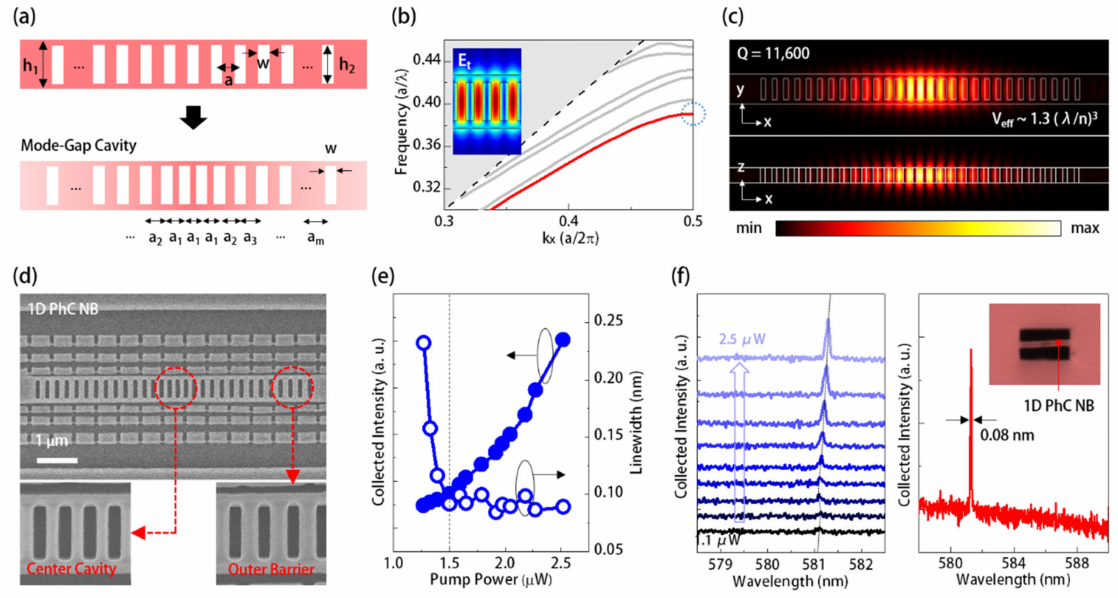
Figure 3. ( a ) Schematics and lattice parameter definitions of 1D PhC NB on a dye-doped PMMA thin film and the nanocavity formed by linearly increased lattice constants; ( b ) theoretical TE -like band diagram of 1D PhC NB with w , h 1 , h 2 , a , and t of 110, 700, 500, 220, and 300 nm; ( c ) theoretical E t distributions of the dielectric mode confined in the 1D PhC NB cavity along XY - and XZ -planes; ( d ) top- and zoom-in view SEM images of 1D PhC NB cavity manufactured by the process in Figure 1b; ( e ) the measured laser emissions/linewidths and ( f ) spectra of 1D PhC dye-laser under different excitation powers; and the inset of ( f ) also shows the optical microscope (OM) image of the 1D PhC NB